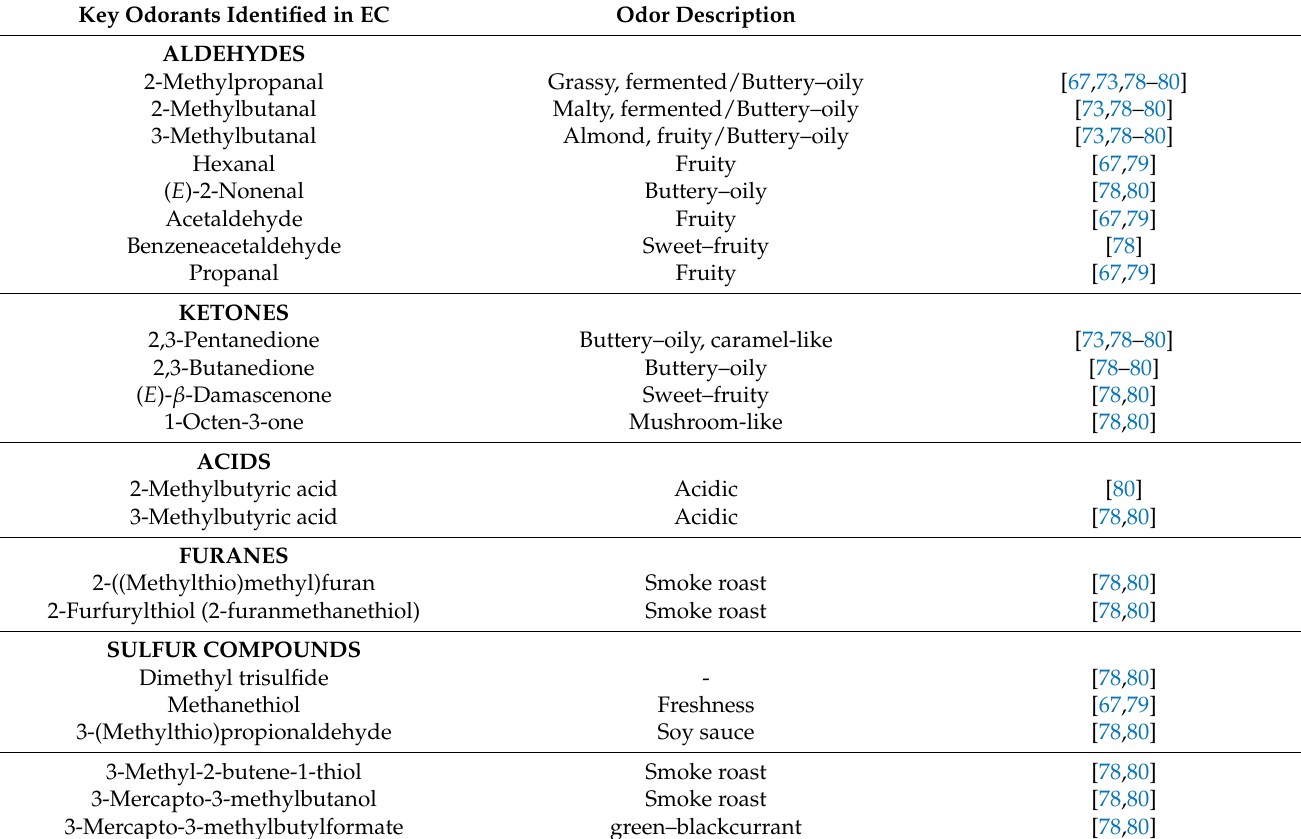
Table 2. The main odor-active compounds A summary of important aroma compounds identified in